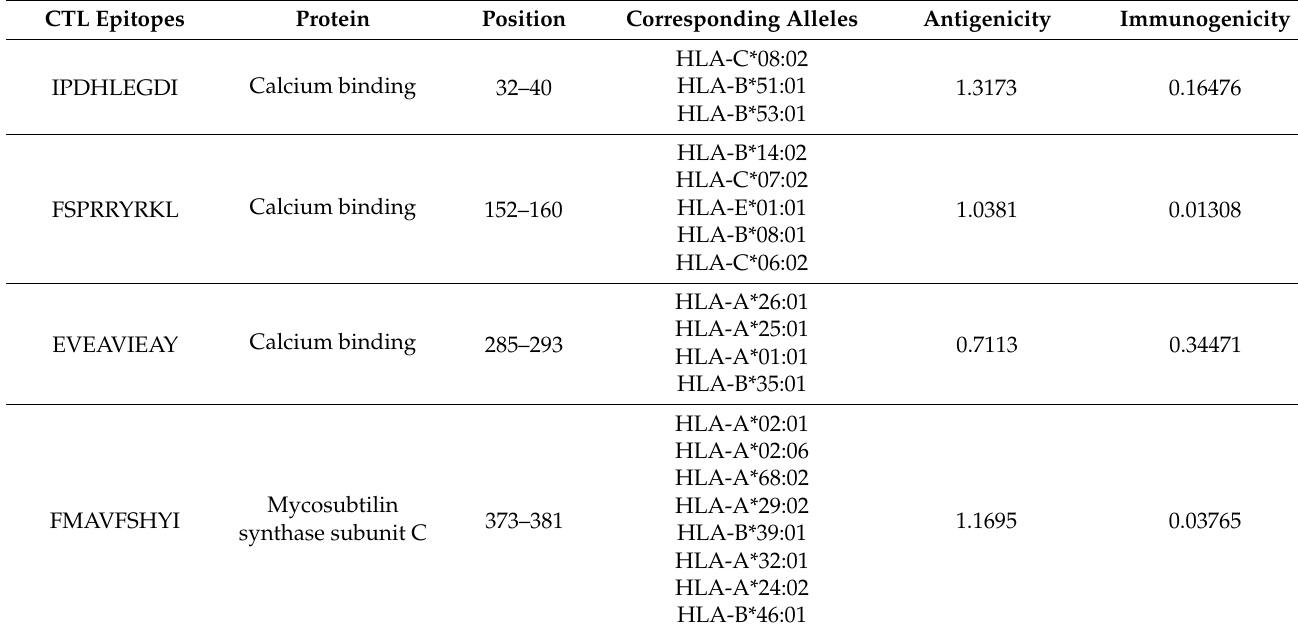
Table 2. Screened CTL epitopes for MEV